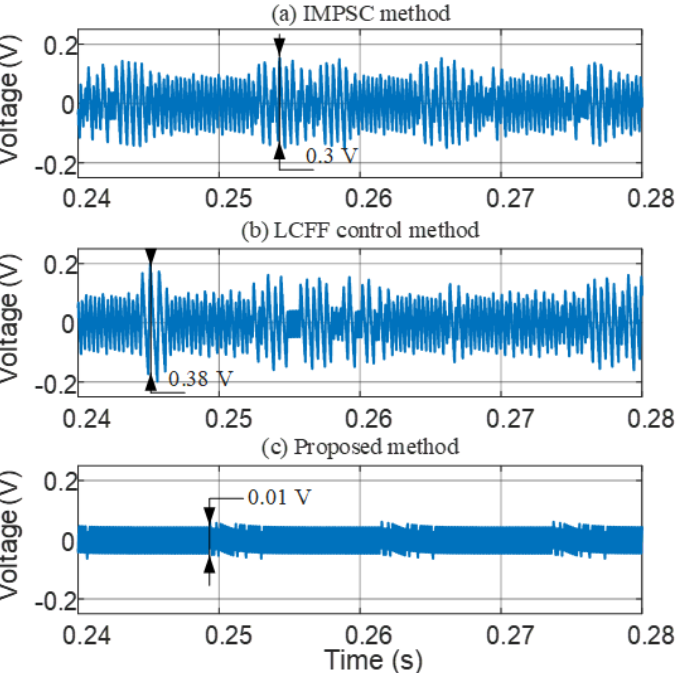
Figure 13. Simulation results for the error between the reference and the output voltage in the steady-state